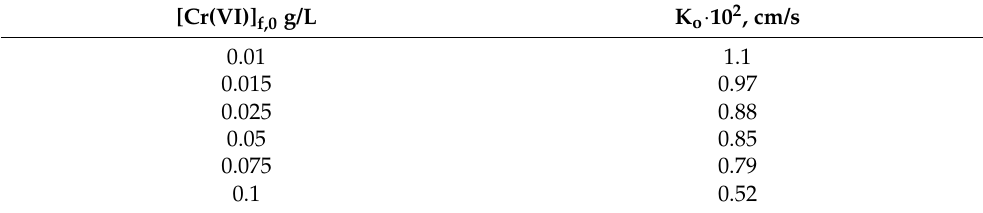
Table 3. Chromium(VI) transport at various initial metal concentrations.